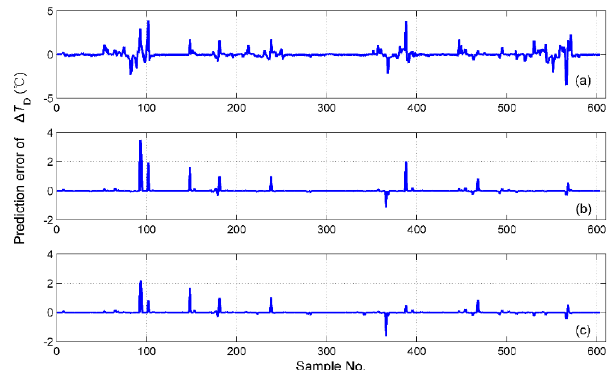
Figure 19. The prediction errors of ∆ T D for di ff erent fusion schemes, namely: ( a ) feature level data fusion; ( b ) decision level data fusion; ( c ) hybrid multi-sensor data fusion.